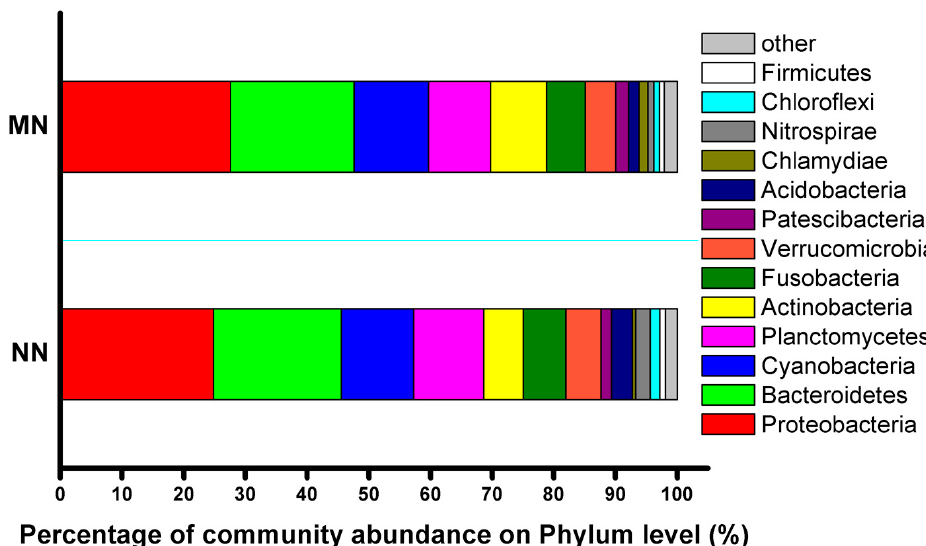
Figure 3. Microbial composition during the experiment. OTU analysis based on the phylum level (n = 3).